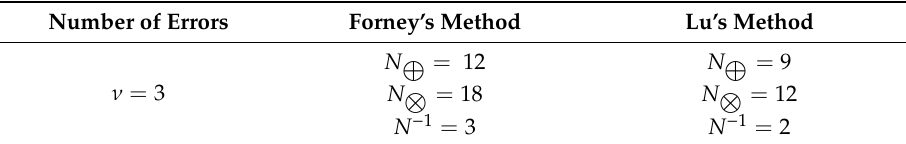
Table 2. Numerical example of equations of Table